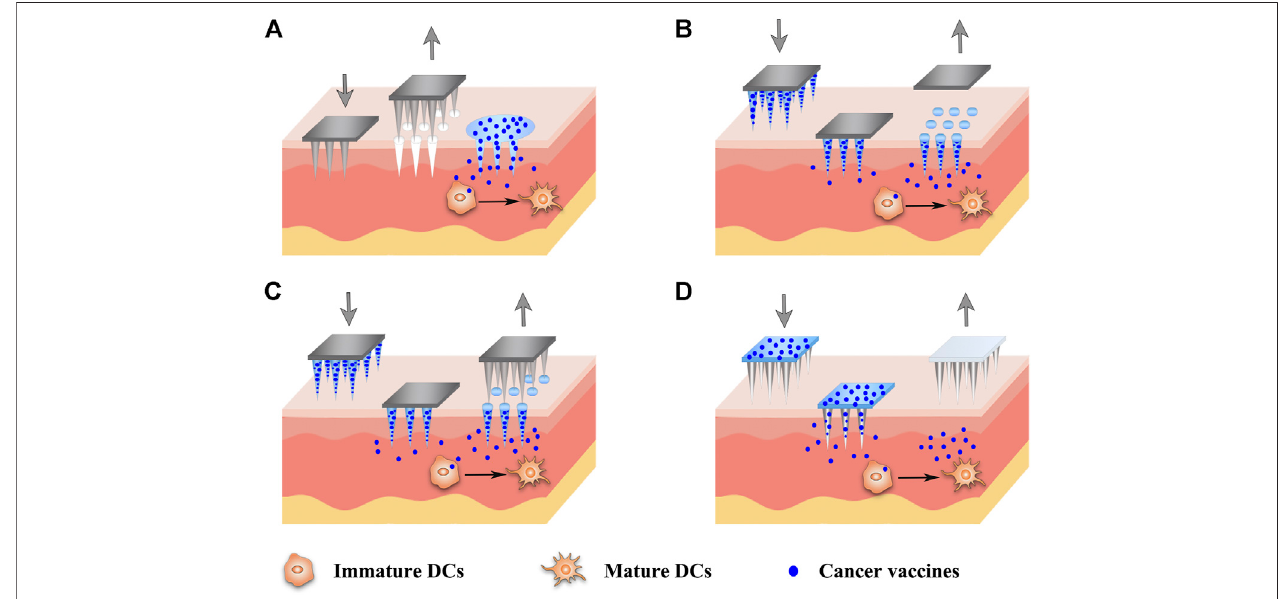
FIGURE 4 | Schematic diagram of strategies of different MN-based cancer vaccines. Various types of MNs have been investigated for the delivery of cancer vaccines, including solid MNs (A) , dissolving MNs (B) , coated MNs (C) and hollow MNs (D) .